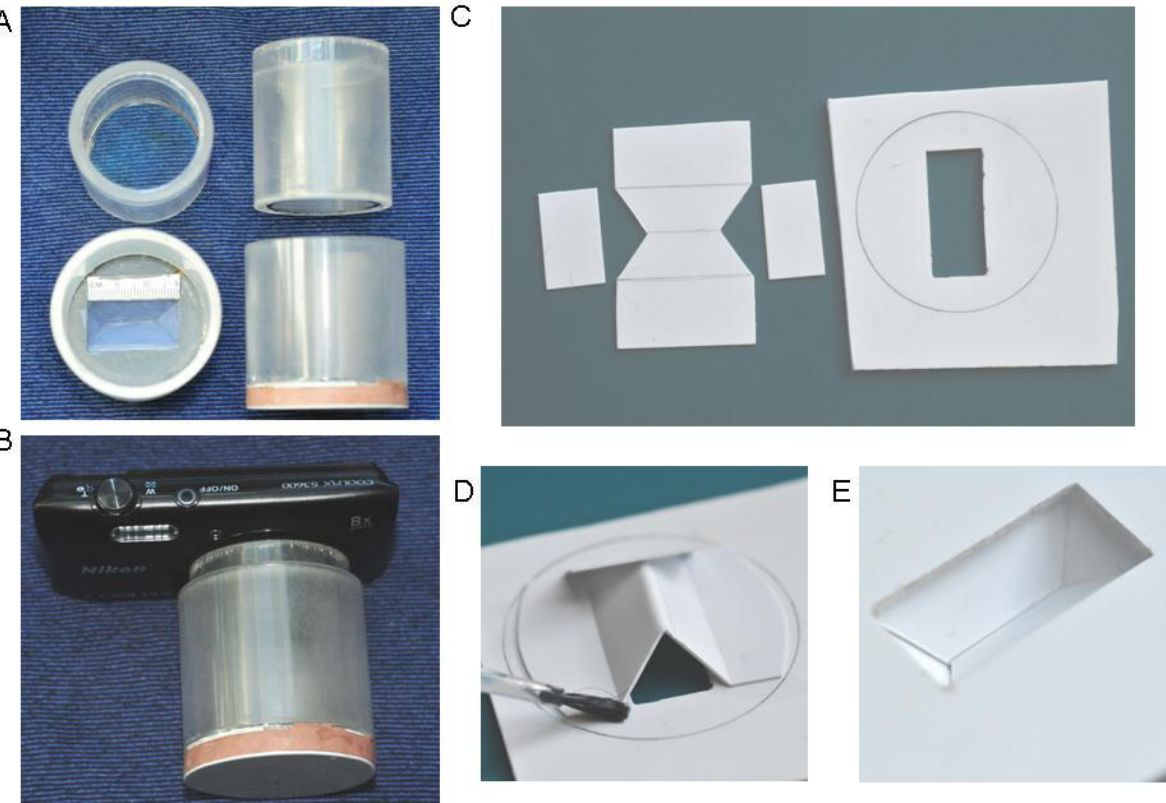
F IGURE 1. Parts of a holder device. (A) End and side views of piston and cylinder. The bee-holding declivity is visible at the bottom of the cylinder. The outside diameter of the cylinder is 50 mm. (B) Nikon Coolpix S3600 camera with lens inserted into piston. (C) Styrene sheet with layout of parts for constructing the declivity that receives the bee. (D) Assembling the declivity with liquid plastic cement. The hourglass-shaped piece is scored and folded along the lines, then cemented in place over the rectangular opening in the bottom plate. In the photo, one of the two end provide a flat bottom, the entire declivity is covered with a thick layer of two-part polyester resin sold for auto body repairs (visible as a pinkish layer in side